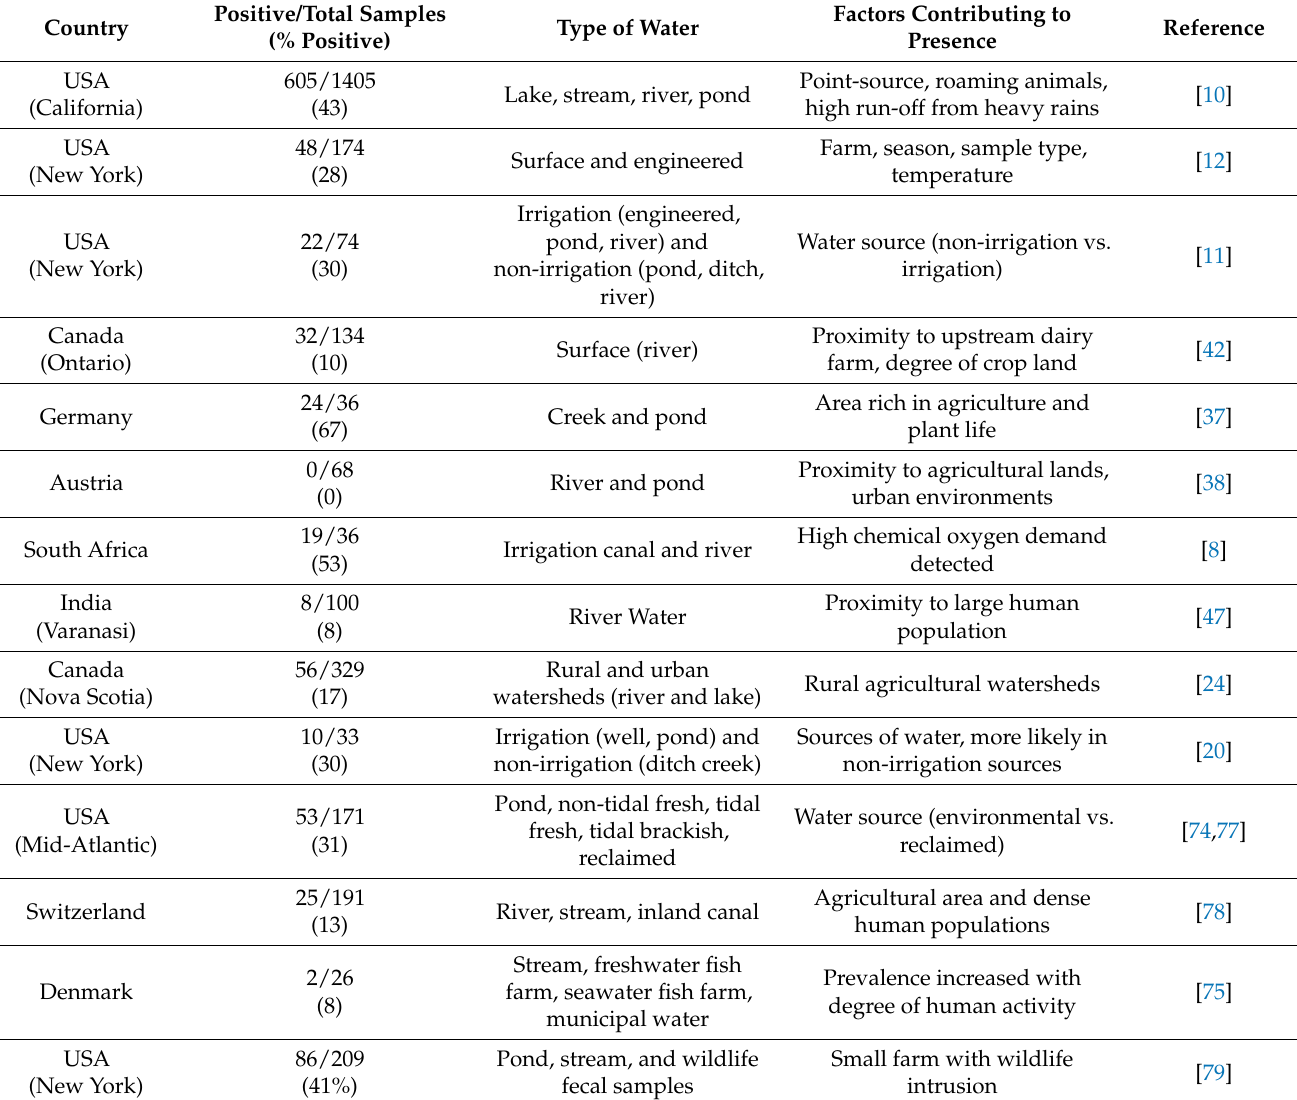
Table 1. Presence and factors attributing to Listeria monocytogenes in water